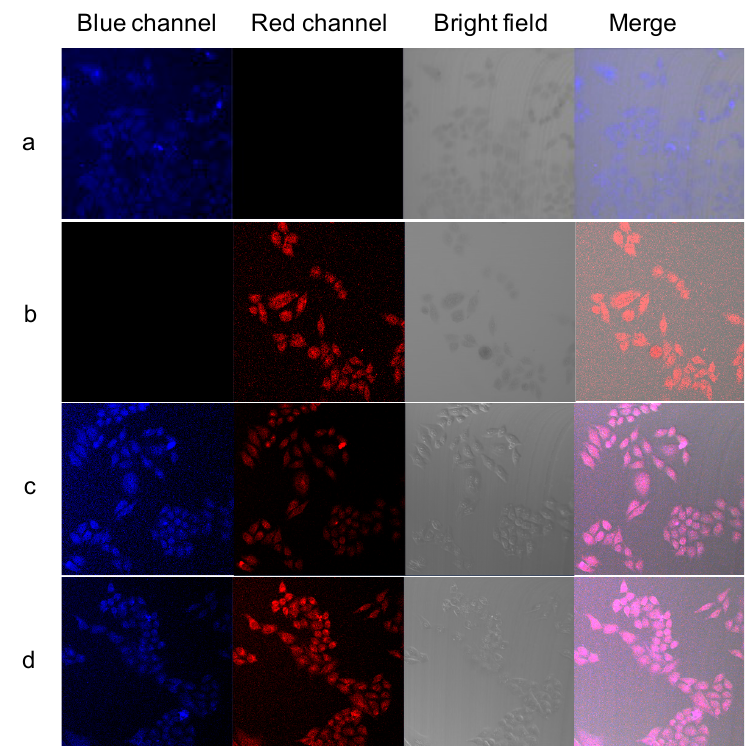
Figure 3. Fluorescent images of HeLa cells incubated with different polymers: ( a ) incubated with P NB ; ( b ) incubated with P NmR ; and ( c , d ) incubated with P MIX ; ( a – c ) were observed at 25 °C and ( d ) was observed at 37 °C.